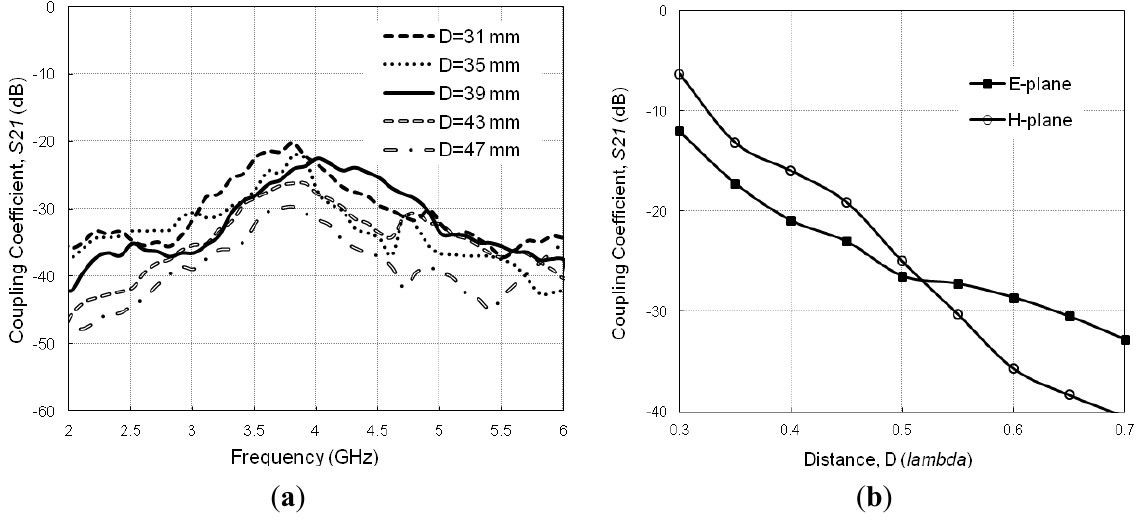
as a function of patch separation, D ( a ) S 21 vs . D for both E and H-plane directions. 21